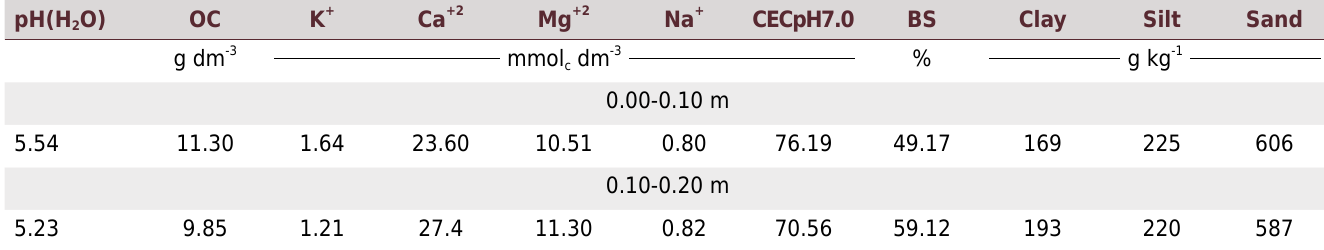
Table 1. Soil chemical properties and particle size distribution of a Typic Hapludult in the 0.00-0.10 and 0.10-0.20 m layers